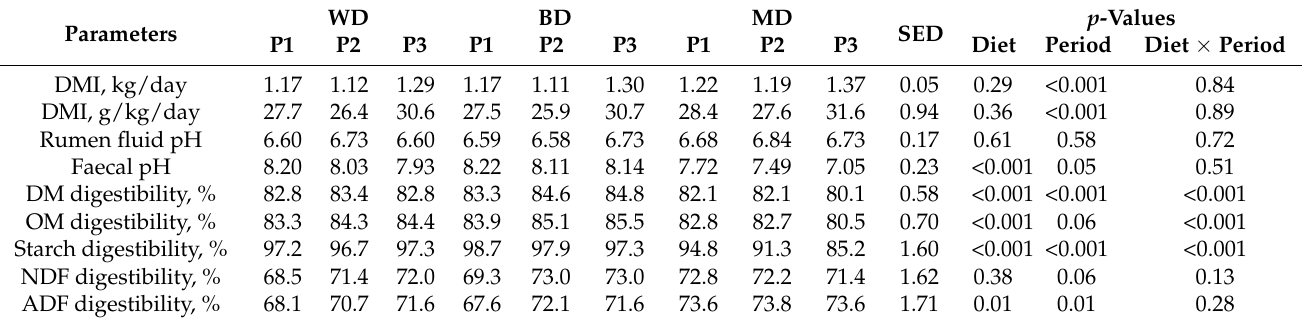
Table 3. Effects of different experimental periods and diet on the DMI, pH, and digestibility variables 1